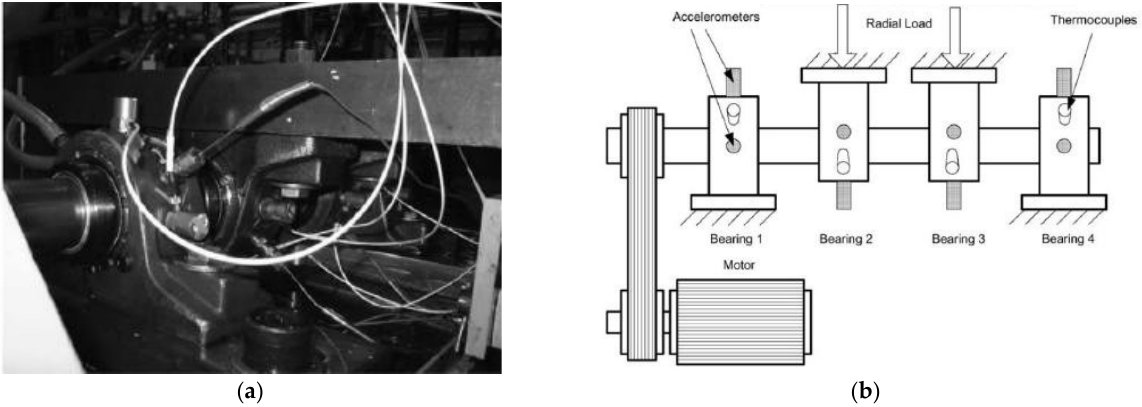
Figure 10. Illustration of the test device: ( a ) Testbed of rolling element bearings; and ( b ) Schematic diagram of the bearing test bench. Table 1. Relevant parameters of the test bearing.